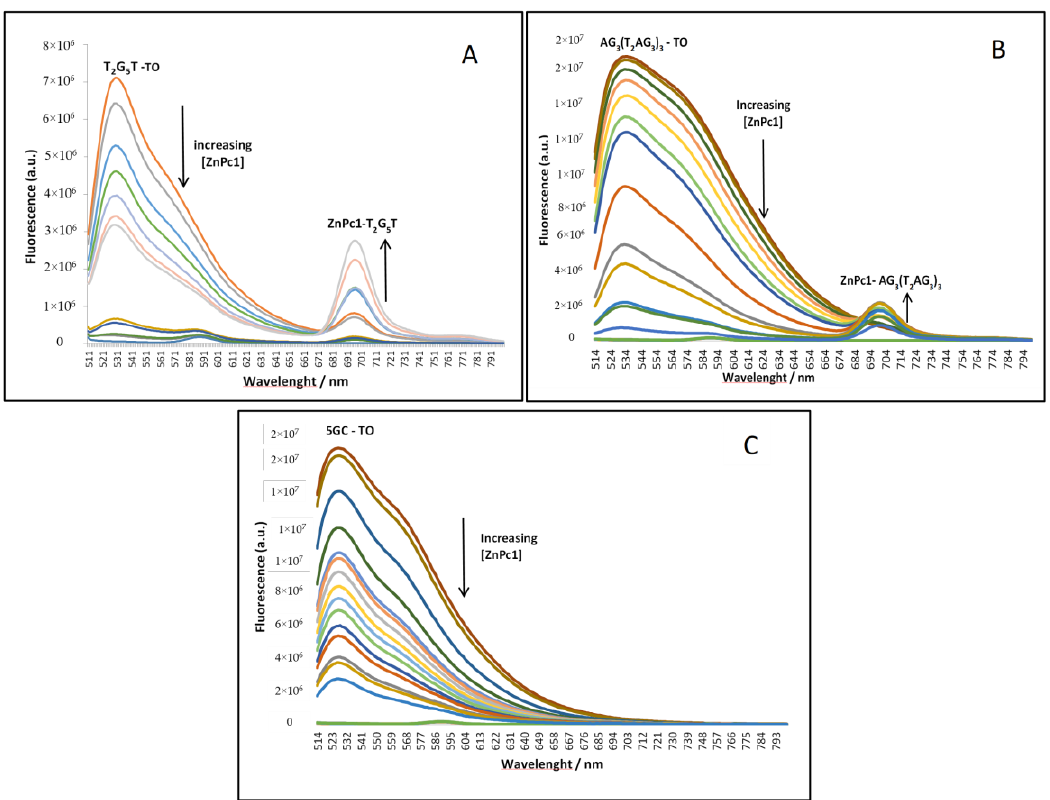
Figure 9. Fluorescence spectra obtained in PBS at 25 °C for ZnPc1 in the concentration range of 0–4.0 uM with ( A ) tetramolecular GQ (T 2 G 5 T) 4 , ( B ) unimolecular GQ AG 3 (T 2 AG 3 ) 3 , and ( C ) duplex sequence 5GC.